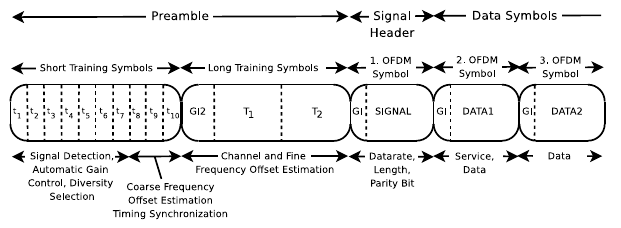
Figure 1: Structure of an OFDM